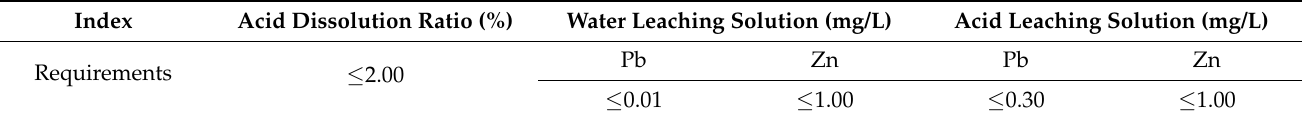
Table 3. The toxicity index of fly ash leaching should be in accordance with the vitrification standard of solid